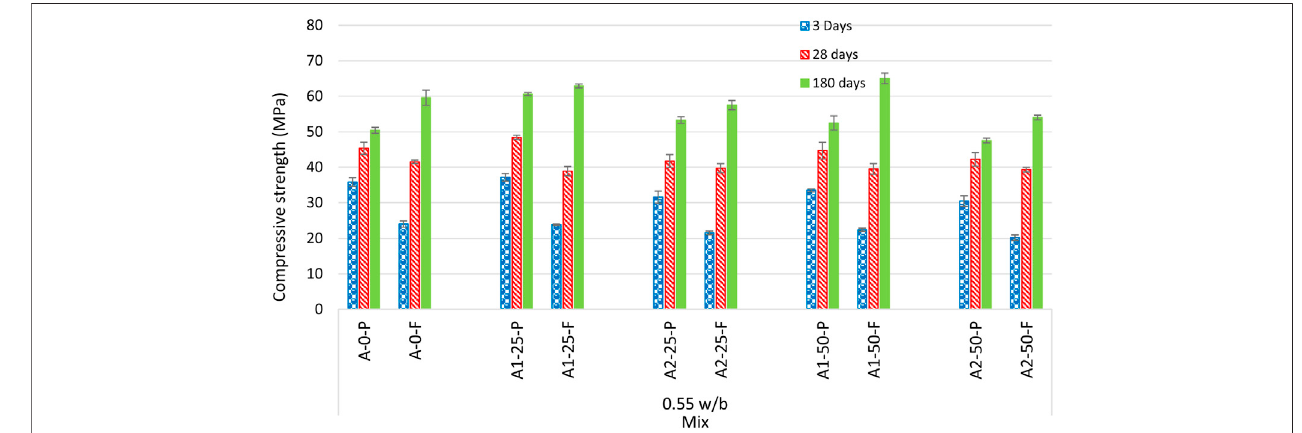
FIGURE 6 | Compressive strength of 0.55 w/b concrete mixes.